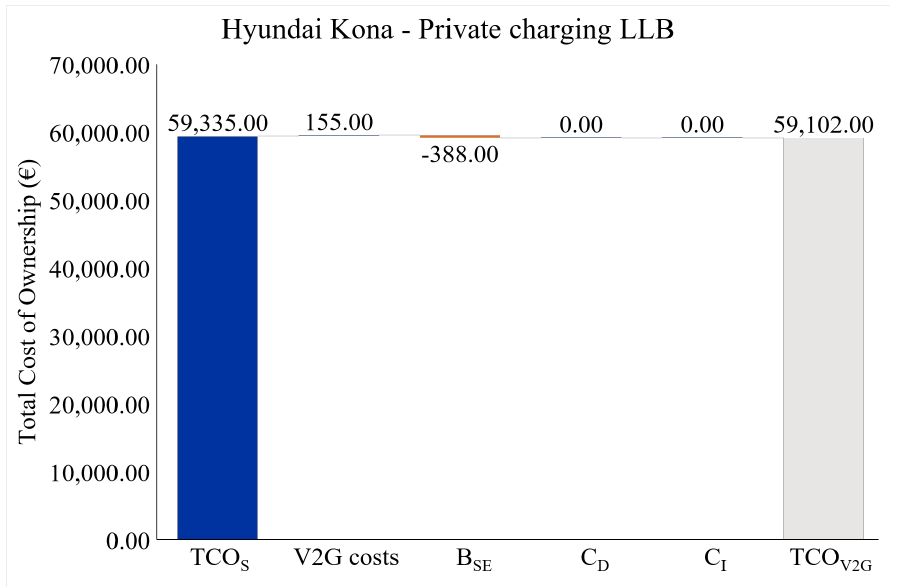
Figure A7. Standard and V2G TCO of a Hyundai Kona in a private charging case providing LLB ( TCO S = Standard TCO, B SE = benefit of saved electricity costs from the grid, C D = direct compensa- tion, C I = indirect compensation, TCO V 2 G = V2G TCO); source: own